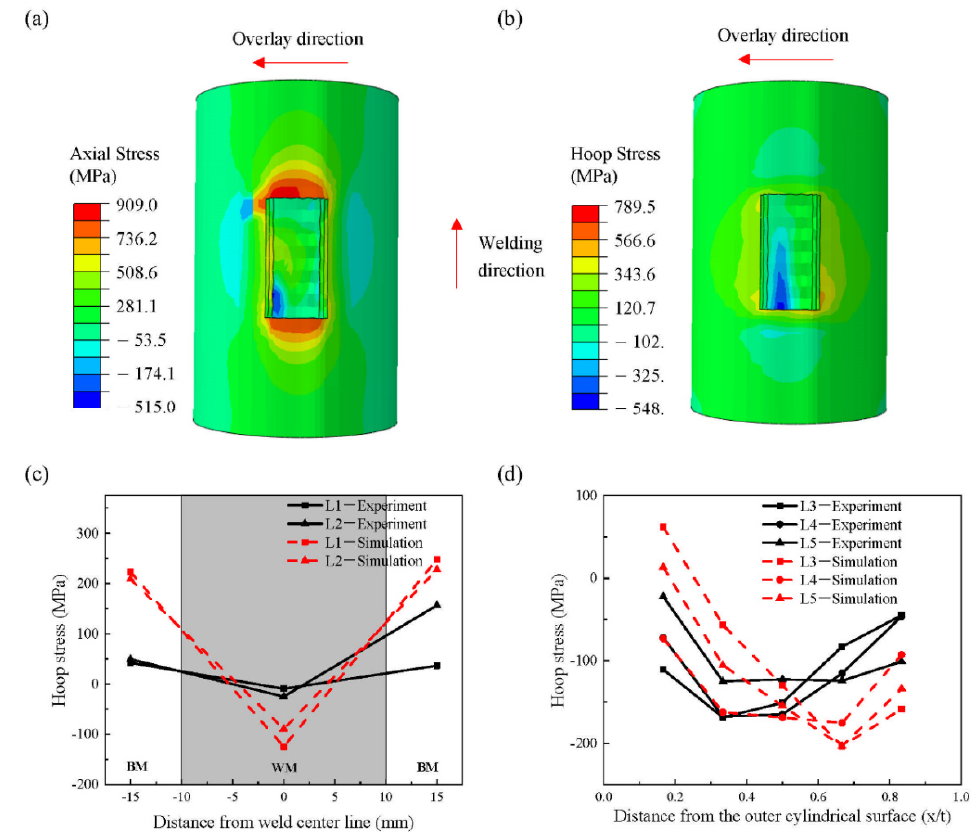
Figure 8. Full field stress distribution on the outer surface of the simulated model after the welding process: ( a ) axial stress, ( b ) hoop stress; comparison of the stress of calculated results and measured results on the outer surface of the sample: ( c ) axial stress, ( d ) hoop stress.